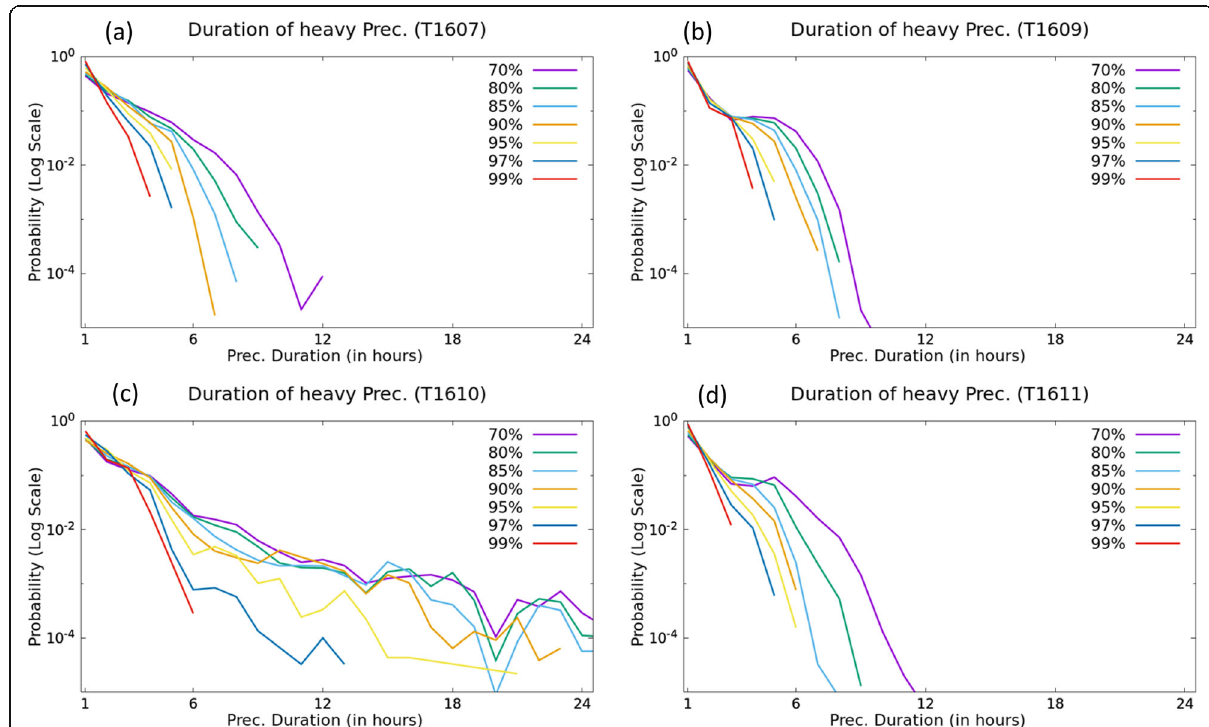
Fig. 4 Duration of heavy precipitations with different thresholds from a Typhoon Chanthu, b Typhoon Mindulle, c Typhoon Lionrock, and d Typhoon Kompasu. Results correspond to the